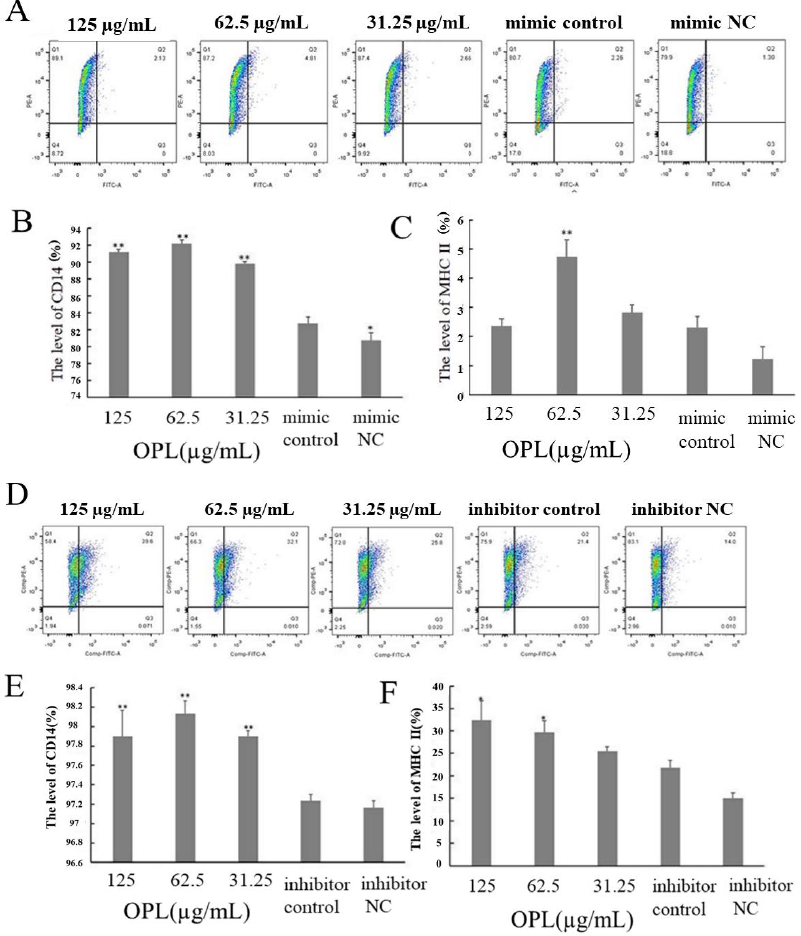
Figure 8. The expression of CD14 and MHC II. ( A ): Flow cytometric analysis of cells transfected with miR-4796 mimic; ( B ): expression level of CD14 in transfected miR-4796 mimic group; ( C ): expression level of MHC II in transfected miR-4796 mimic group; ( D ): flow cytometric analysis of cells transfected with miR-4796 inhibitor; ( E ): expression level of CD14 in transfected miR-4796 inhibitor group; ( F ): expression level of MHC II in transfected miR-4796 inhibitor group. Each value represents the mean ± SD ( n = 3). * p < 0.05, ** p < 0.01 compared with the control group.